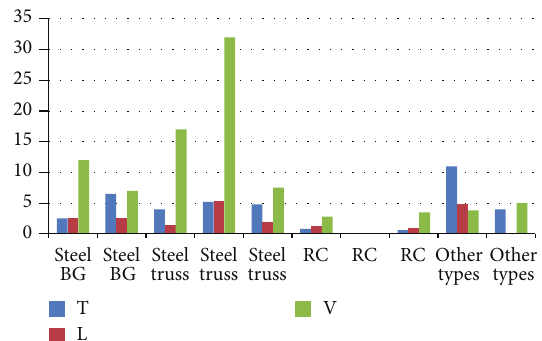
Figure 9: Amplitude values in mg of the measured maximum motion at mid-span (T; L; V): 1 person walking at “normal” pace (2Hz) in different typologies (Series